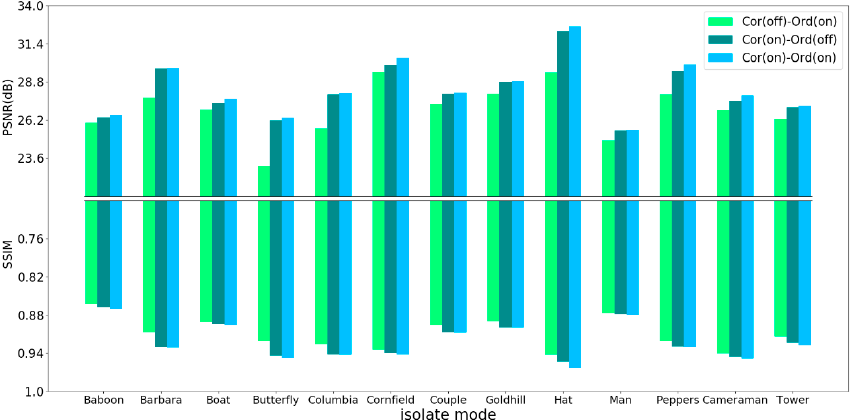
Figure 13. The influence of the proposed correction and adaptive scan order to the final error concealment (EC) performance under the 16 × 16 regular isolated loss mode.